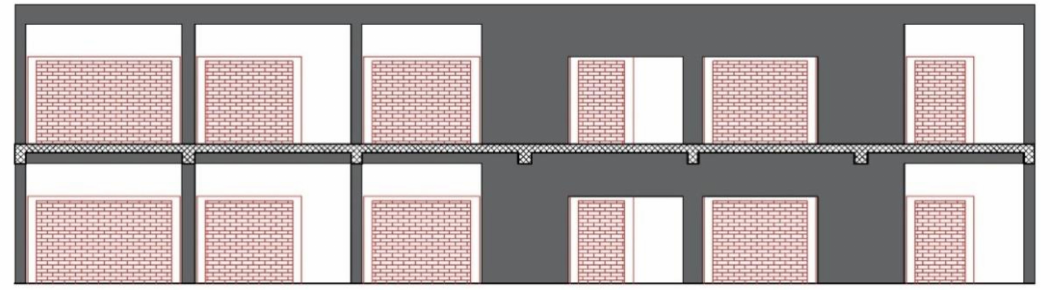
Figure 6. PREbuilding type: schematic view for the retrofitting intervention A 3